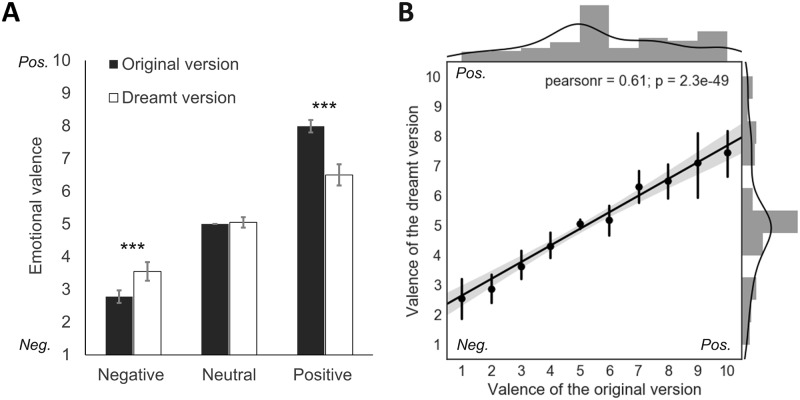
Emotional valence of the dreamt version and the original version of the WLEs incorporated into dreams.A) Emotional valence of the dreamt version (white bars) and the original version (black bars) of the WLEs incorporated into dreams for positive (rating > 5), neutral (rating = 5) and negative (rating < 5) elements. The dreamt version was scored as more neutral than the original version of the WLEs. B) Significant positive correlation between the emotional valence ratings of the original and the dreamt versions of the WLEs incorporated into dreams. Gray bars indicate the distribution of the ratings for the original and the dreamt version of the WLEs incorporated into dreams. Error bars represent 95% confidence intervals. *** p <.001.